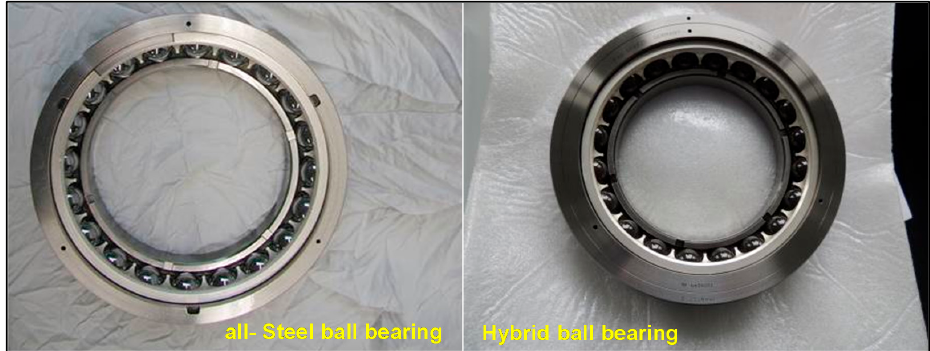
Figure 2. Pictures of the tested bearings. The hybrid version incorporates Squeeze film damping as an additional feature.